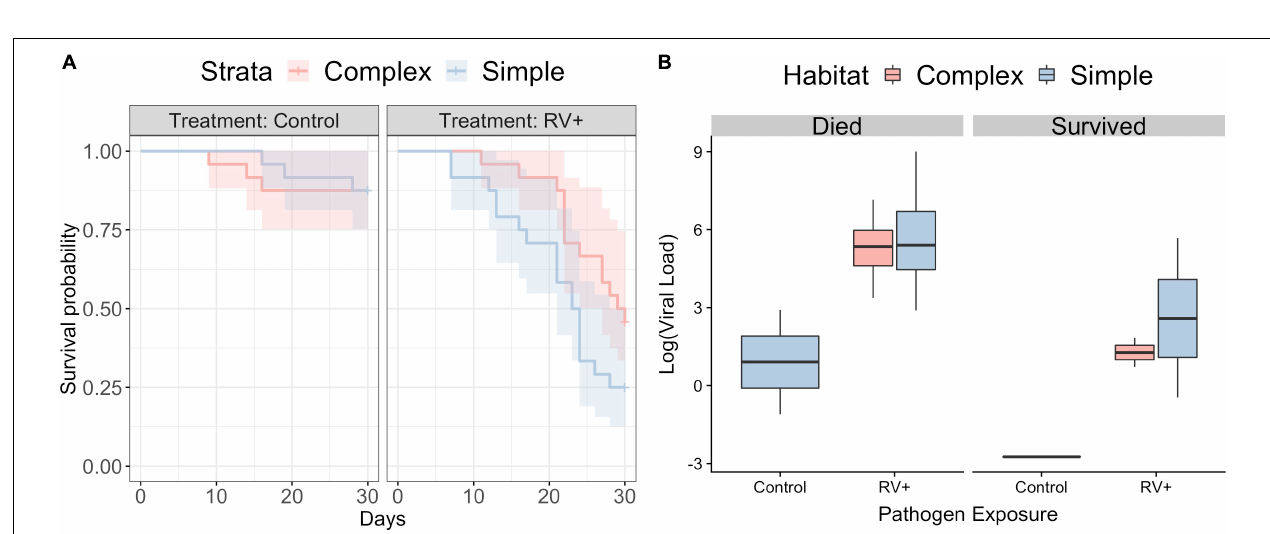
FIGURE 2 | Survival following exposure to ranavirus. (A) Survival data for frogs exposed to Ranavirus or Control, in both Complex (red shading) and Simple (blue shading) habitats. The top model explaining variation in survival contained effects of both habitat and pathogen exposure. The model containing the habitat:pathogen interaction was not retained under the nesting rule. (B) Ranaviral infection loads following exposure to ranavirus, split by whether individuals died following exposure or were still alive on Day 30 at the close of the experiment. There was no difference in ranaviral infection burdens based on habitat treatment, but individuals that died had significantly higher infection loads. Three individuals in the control group exhibited weak infection.